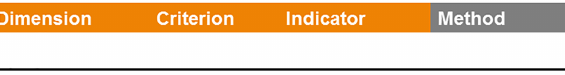
Figure 3. The evaluation cascade from the general scale to assess- ment methods in detail; whereas dimensions, criteria and indicators are covered by literature – although with very different intensity and to a very different extent – the methods mentioned in this article are suggestions by the author (in a separate column in